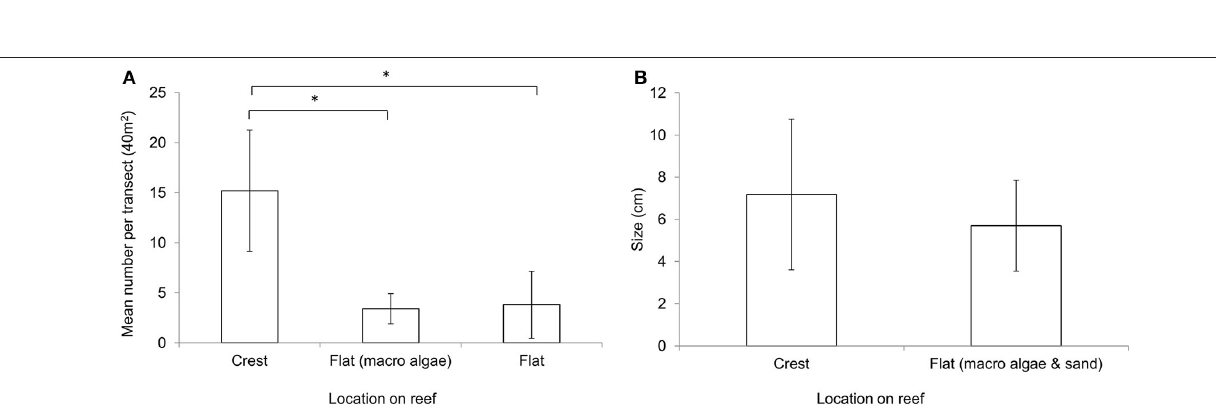
FIGURE 4 | (A) Mean abundance of Lithophyllum kotschyanum on the reef crest, macroalgae dominated reef flat, sand dominated reef flat ( n = 5 ± StDev). Each transect covered 40 m 2 . *Indicates significant difference at p < 0.05. (B) Mean size of Lithophyllum kotschyanum on the reef crest and reef flat measured along the longest axis ( n = 30 ±